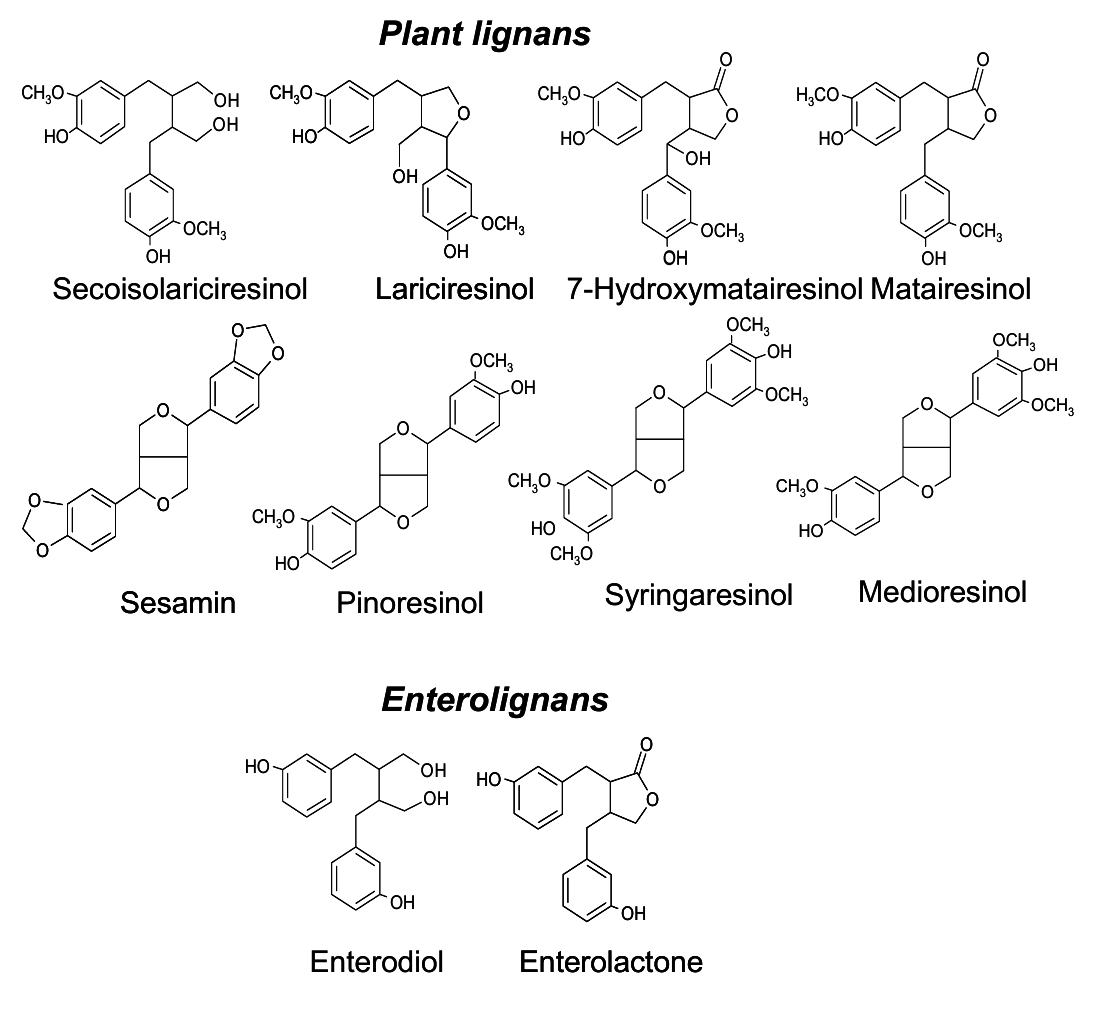
Figure 1 . Chemical structures of most abundant dietary plant lignans and their enterolignan